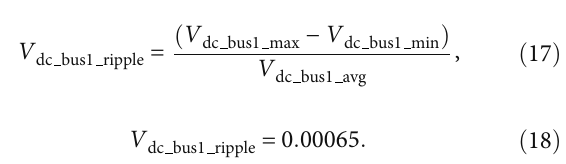
. (b) Input current I inopen